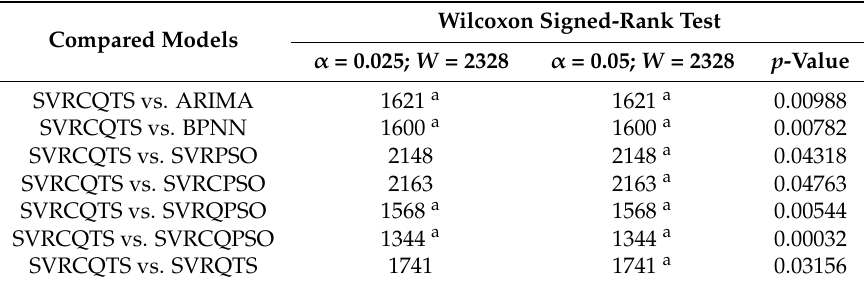
Table 8. Wilcoxon signed-rank test (Example 3).